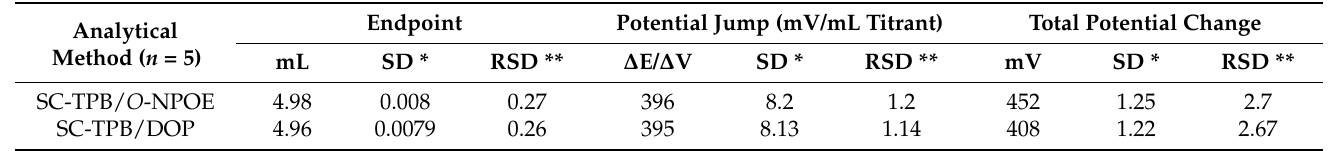
Table 3. The precision of the potentiometric titration of 5.0 mL of 1.0 × 10 − 2 M of SC solution with